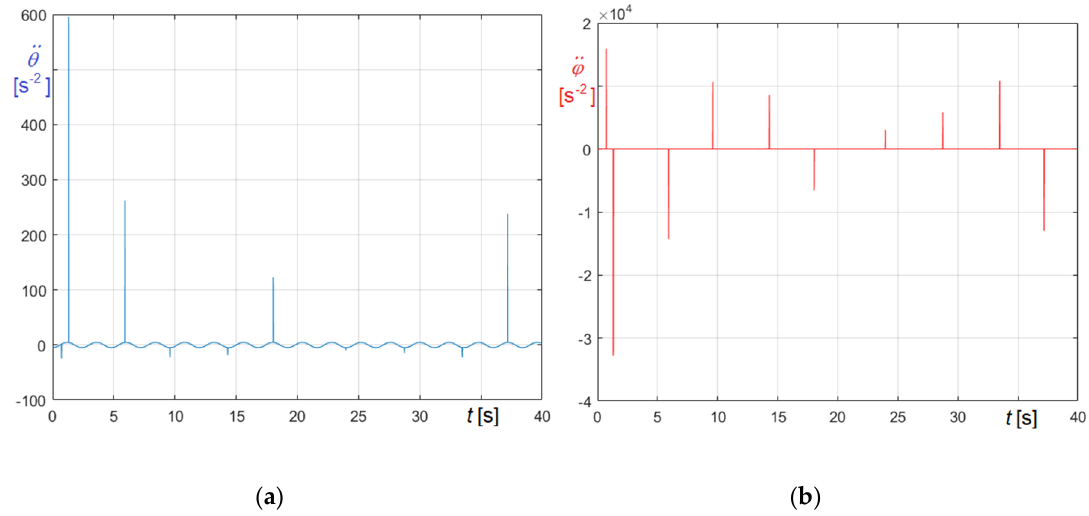
√ (cid:17) (cid:16) K = 0.2 − ∆ t = 0.1 ms :